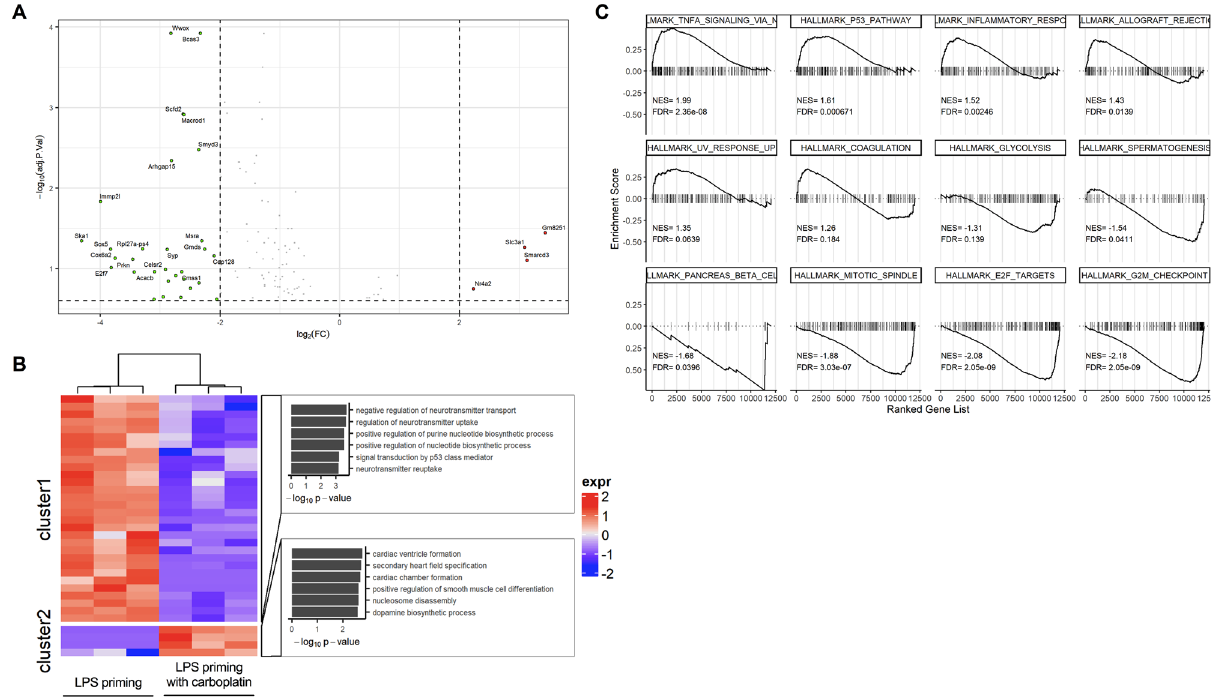
Figure 3. Transcriptomics of LPS-primed macrophages in the presence of carboplatin. ( A ) BMDMs were pretreated with or without carboplatin (25 μM) for 1 h before stimulation with LPS (100 ng/ml) for 24 h. RNA- Seq was performed as described in the “Materials and methods”. Volcano plot showing DEGs of LPS-primed macrophages with or without carboplatin. |log2FC| > 2, p < 0.25. ( B ) Heatmap and GO terms associated with DEGs. ( C ) GSEA showing positive and negative hallmark gene sets in LPS-primed macrophages treated with